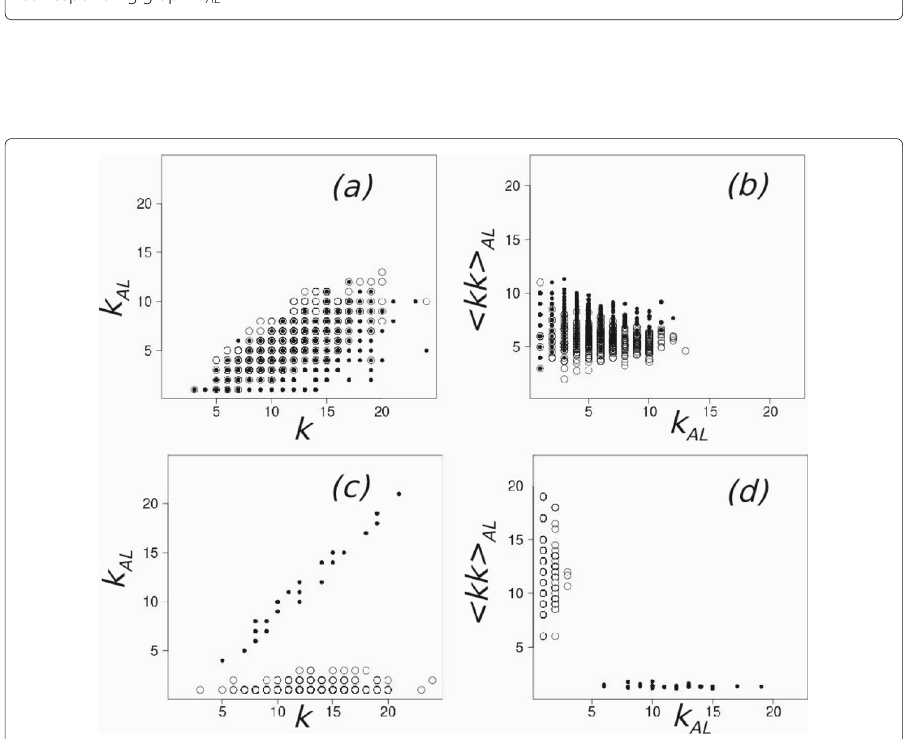
Fig. 2 Snapshots and degree distribution of G AL for Erdos-Renyi contact network of < k > = 12 with N = 1000 agents. Upper panels a and b correspond to ρ = 0.47. Down panels c and d correspond to ρ = 0.026. Left panels a , c : degree of the nodes in G AL ( k AL ) versus the degree of the nodes in the underlying static network ( k ). Right panels b , d : degree correlation of G AL for each agent of G